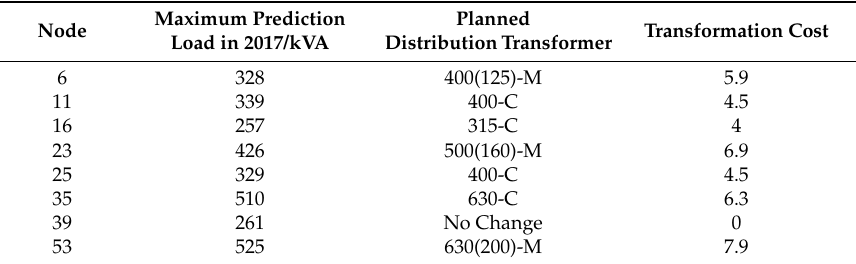
Table 7. Planning scheme of distribution transformers with certain